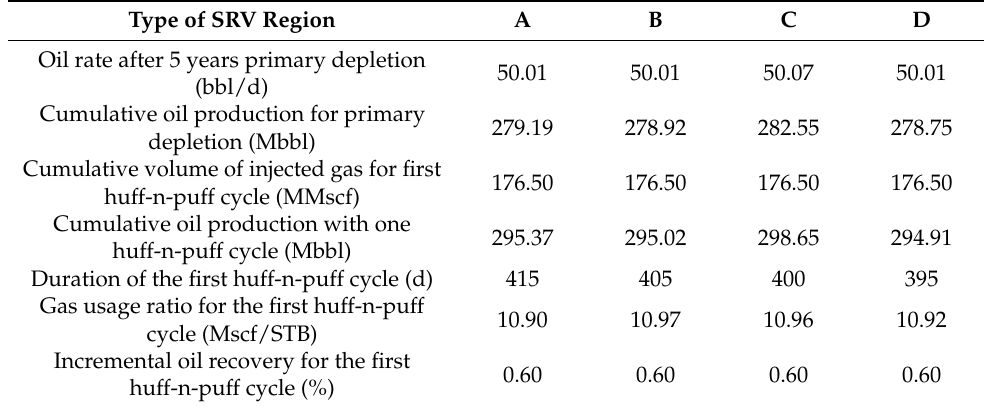
Figure 21. Four types of SRV region: ( A ) No stimulation around main hydraulic fractures; ( B ) Stimulation within 10 m of the single wing; ( C ) Stimulation within 10 m of the bi-wing; ( D ) Stimulation within 20 m of the single wing. The red grid indicates hydraulic fractures. The orange grid represents the SRV region. The white grid denotes matrix. Table 15. Summary of results for huff-n-puff with different types of SRV region.